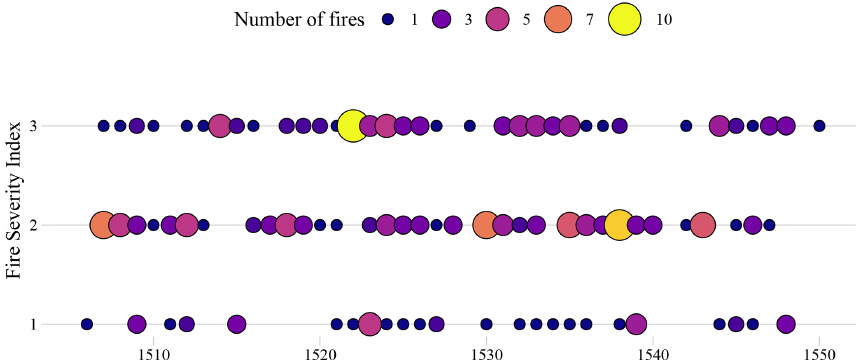
Figure 9. Index of fire severity categories. Source: Archival sources AS 4.